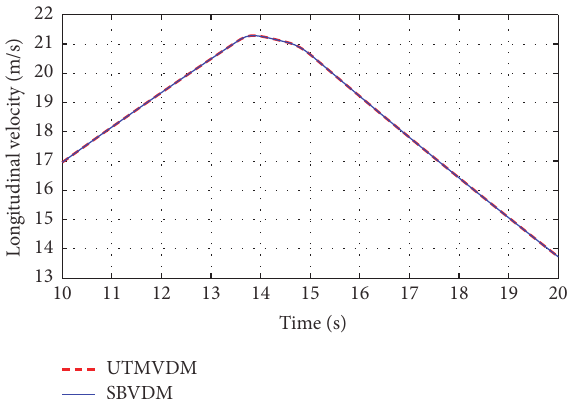
Figure10: Longitudinalvelocity responsesforaccelerating and hard braking scenario.